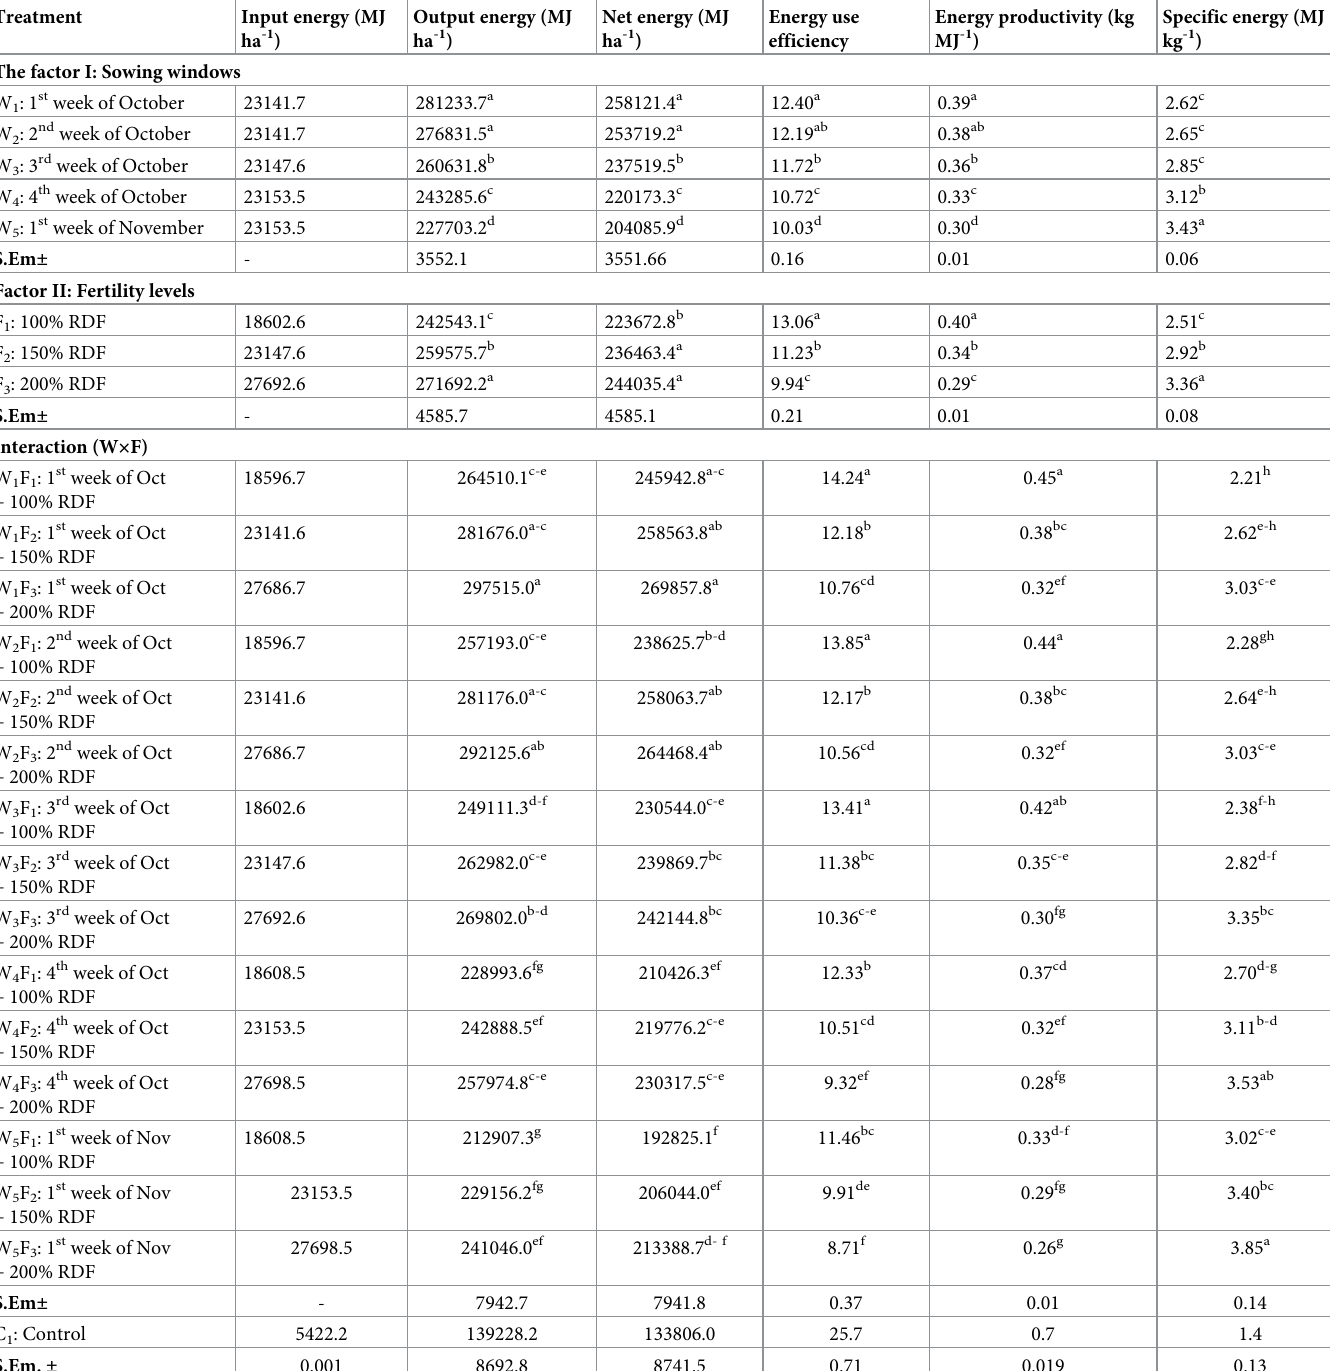
Table 5. Energetics of winter maize as influenced by sowing windows and fertility levels.